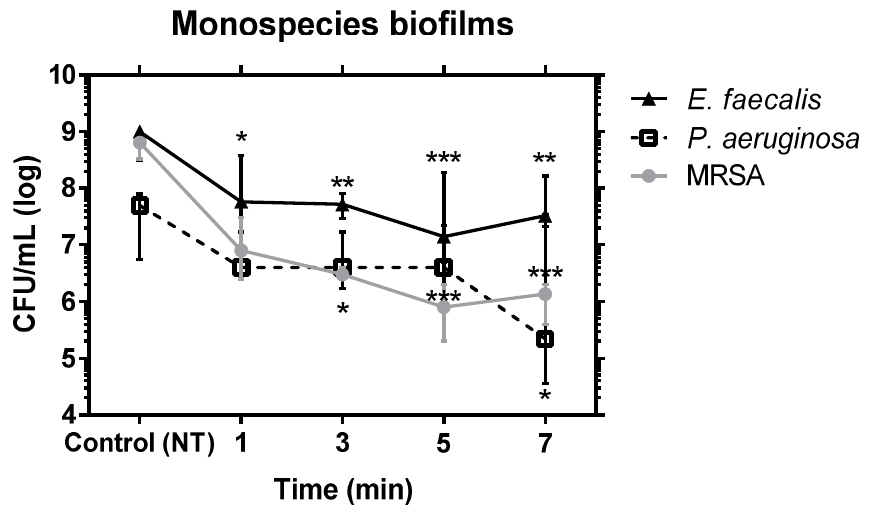
Figure 1. Median and interquartile range of MRSA, P. aeruginosa and E. faecalis viable cells (CFU/mL) recovered after exposure of monospecies biofilms to (CAP) for 1, 3, 5 and 7 min. Kruskal–Wallis test and Dunn’s multiple comparison * p < 0.05; ** p < 0.01; *** p < 0.001.